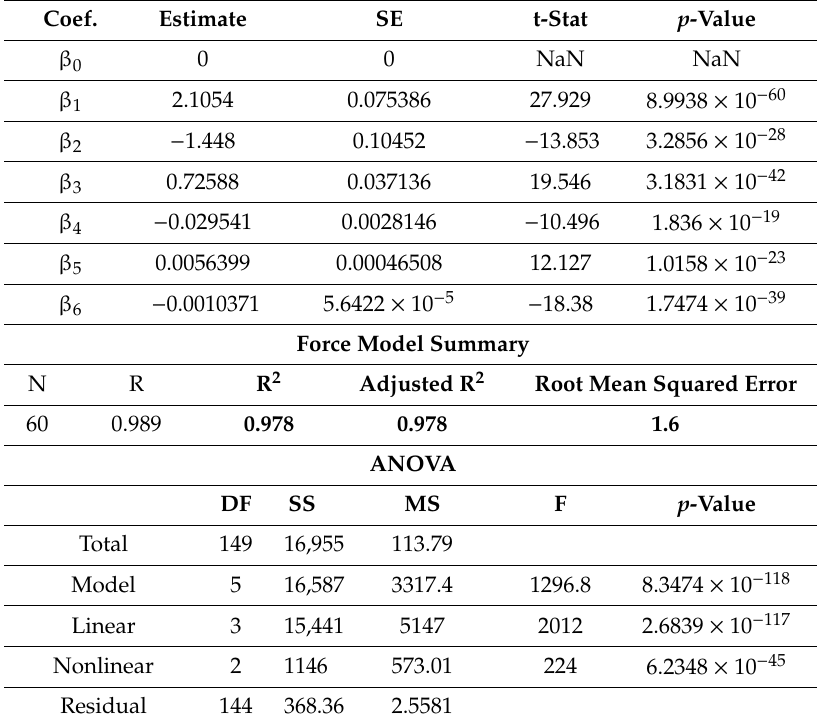
Table 3. Results of